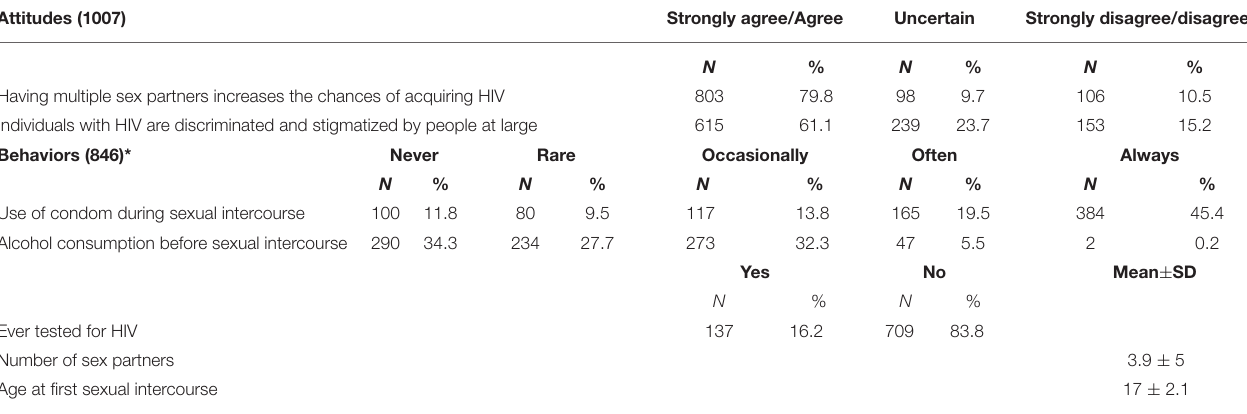
TABLE 2 | Respondents’ attitudes toward HIV infection and self-reported sexual and testing behaviors. Attitudes (1007) Strongly agree/Agree